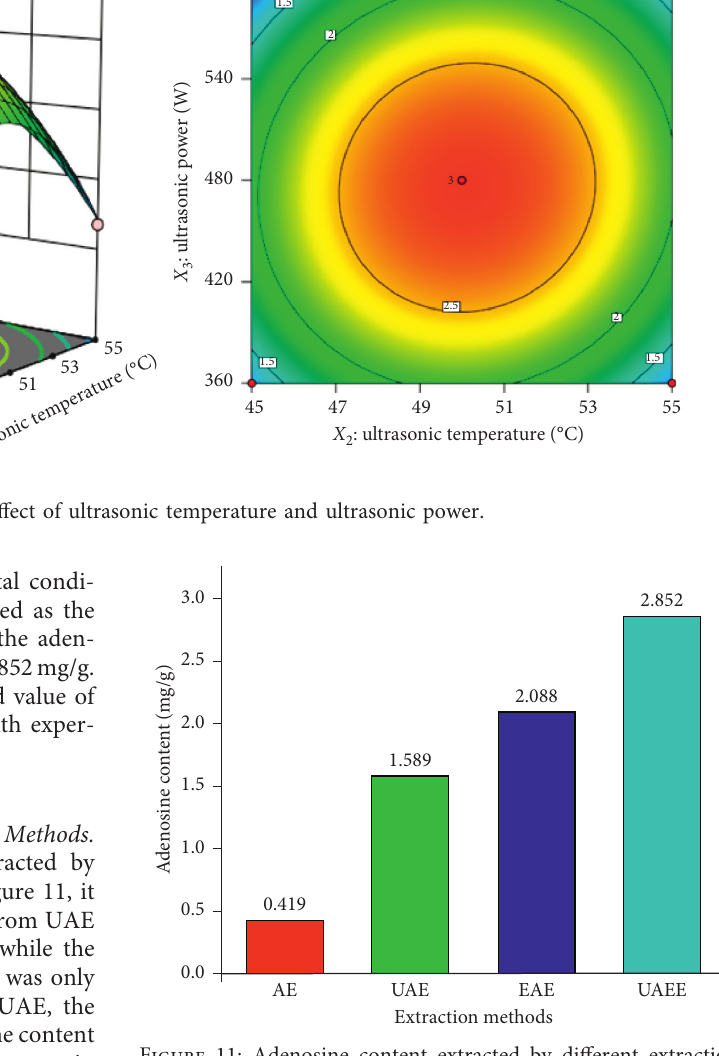
Figure 11: Adenosine content extracted by different extraction